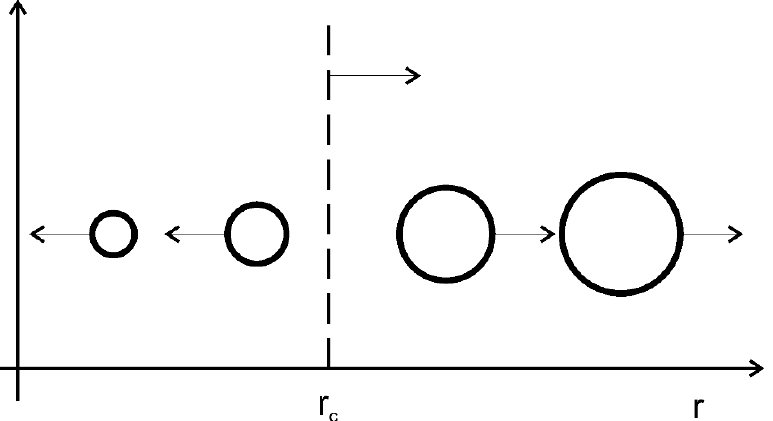
Figure 5. Diffusion coarsening scheme. Big particles grow, small particles dissolute. Open access from Razumovskii I.M. et al. [29].